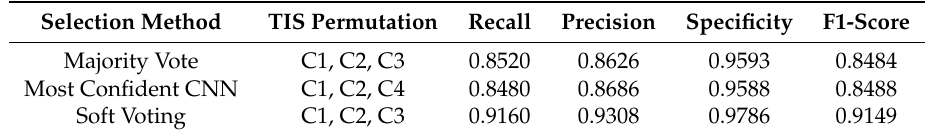
Table 10. Pose recognition results achieved using permutations of three corner TISs with three methods of prediction